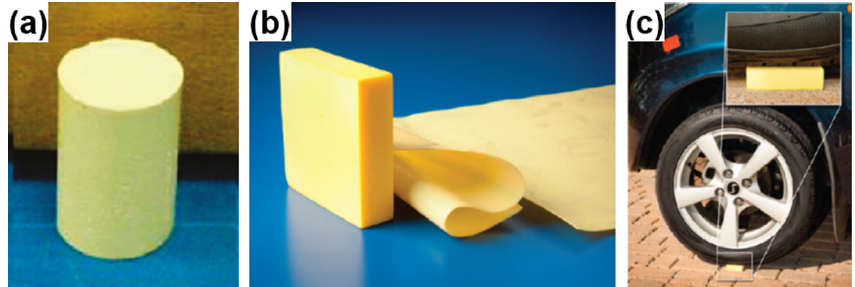
Figure 5. ( a ) Octa(aminophenyl) ‐ silsesquioxane (OAPS) cross ‐ linked polyimide aerogels; ( b ) polyimide aerogels cross ‐ linked with 1,3,5 ‐ triaminophenoxybenzene (TAB) fabricated as flexible thin films or molded to a net shape; and ( c ) demonstrating strength of the aerogel by supporting the weight of a car. Reproduced with permission of [99] (Copyright American Chemical Society 2012).